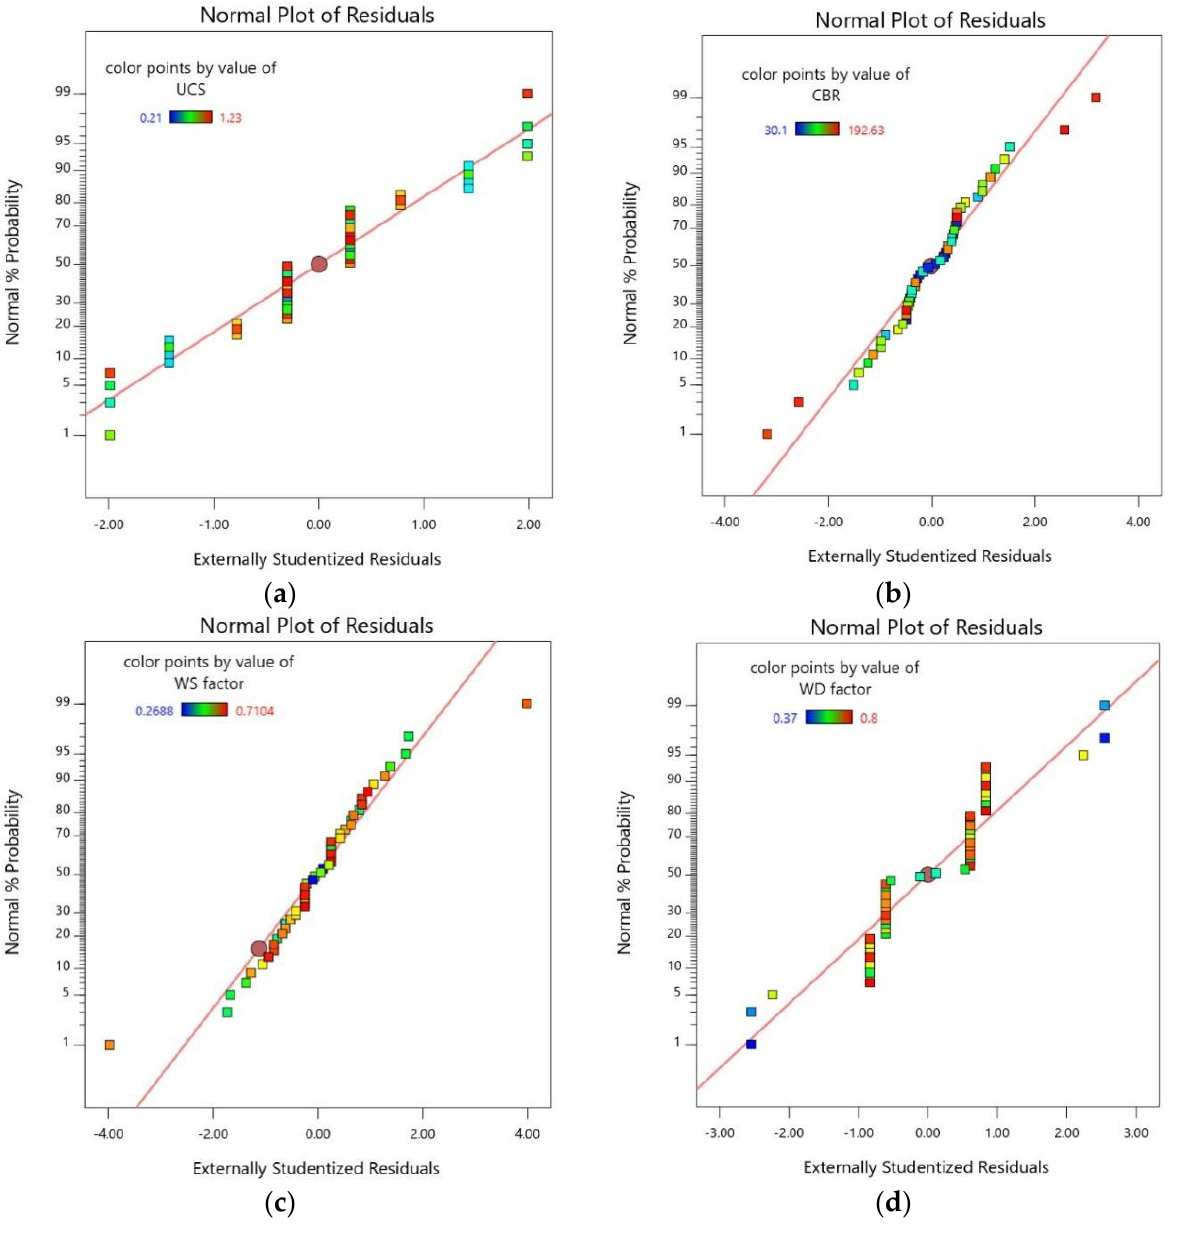
Figure 8. Positive probability distribution of ( a ) UCS model residual, ( b ) CBR model residual, ( c ) WS factor model residual and ( d ) WD factor model residual.